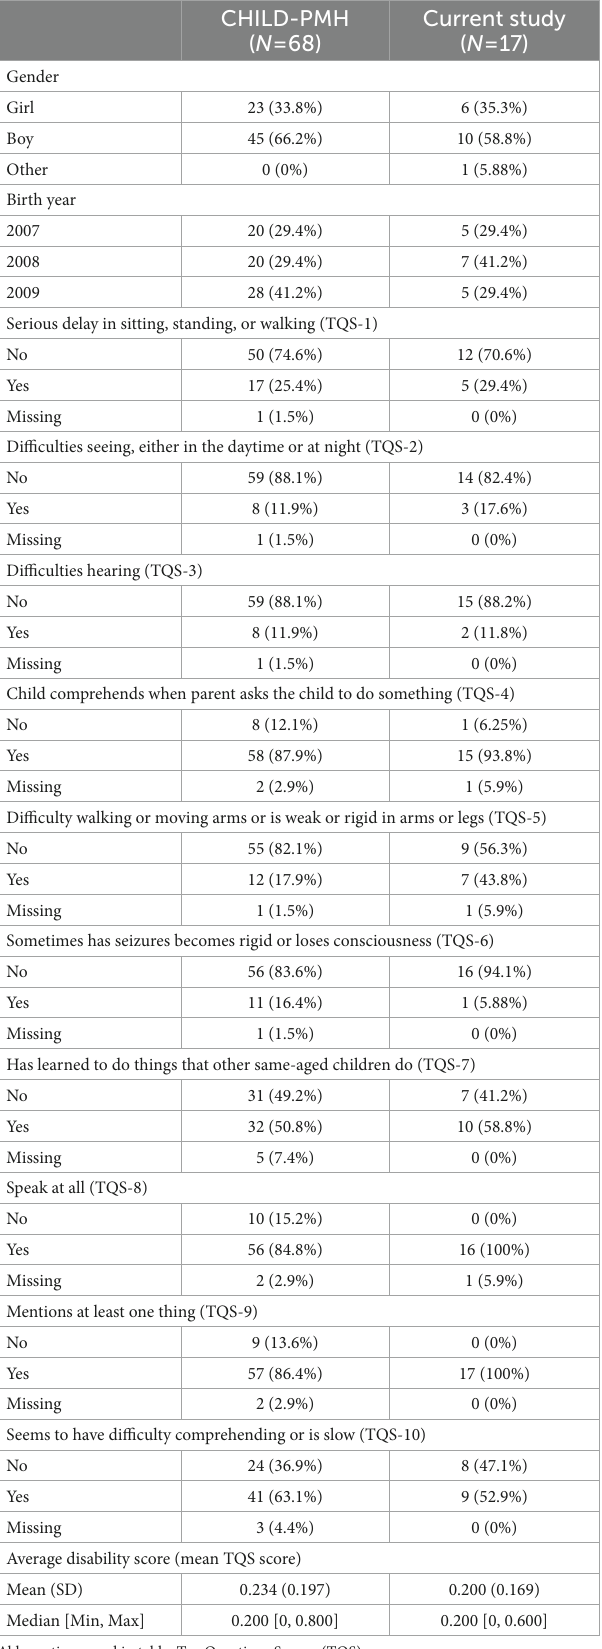
TABLE 1 Characteristics of the participants in the current study and the rest of the children in the older cohort of the CHILD-PMH longitudinal